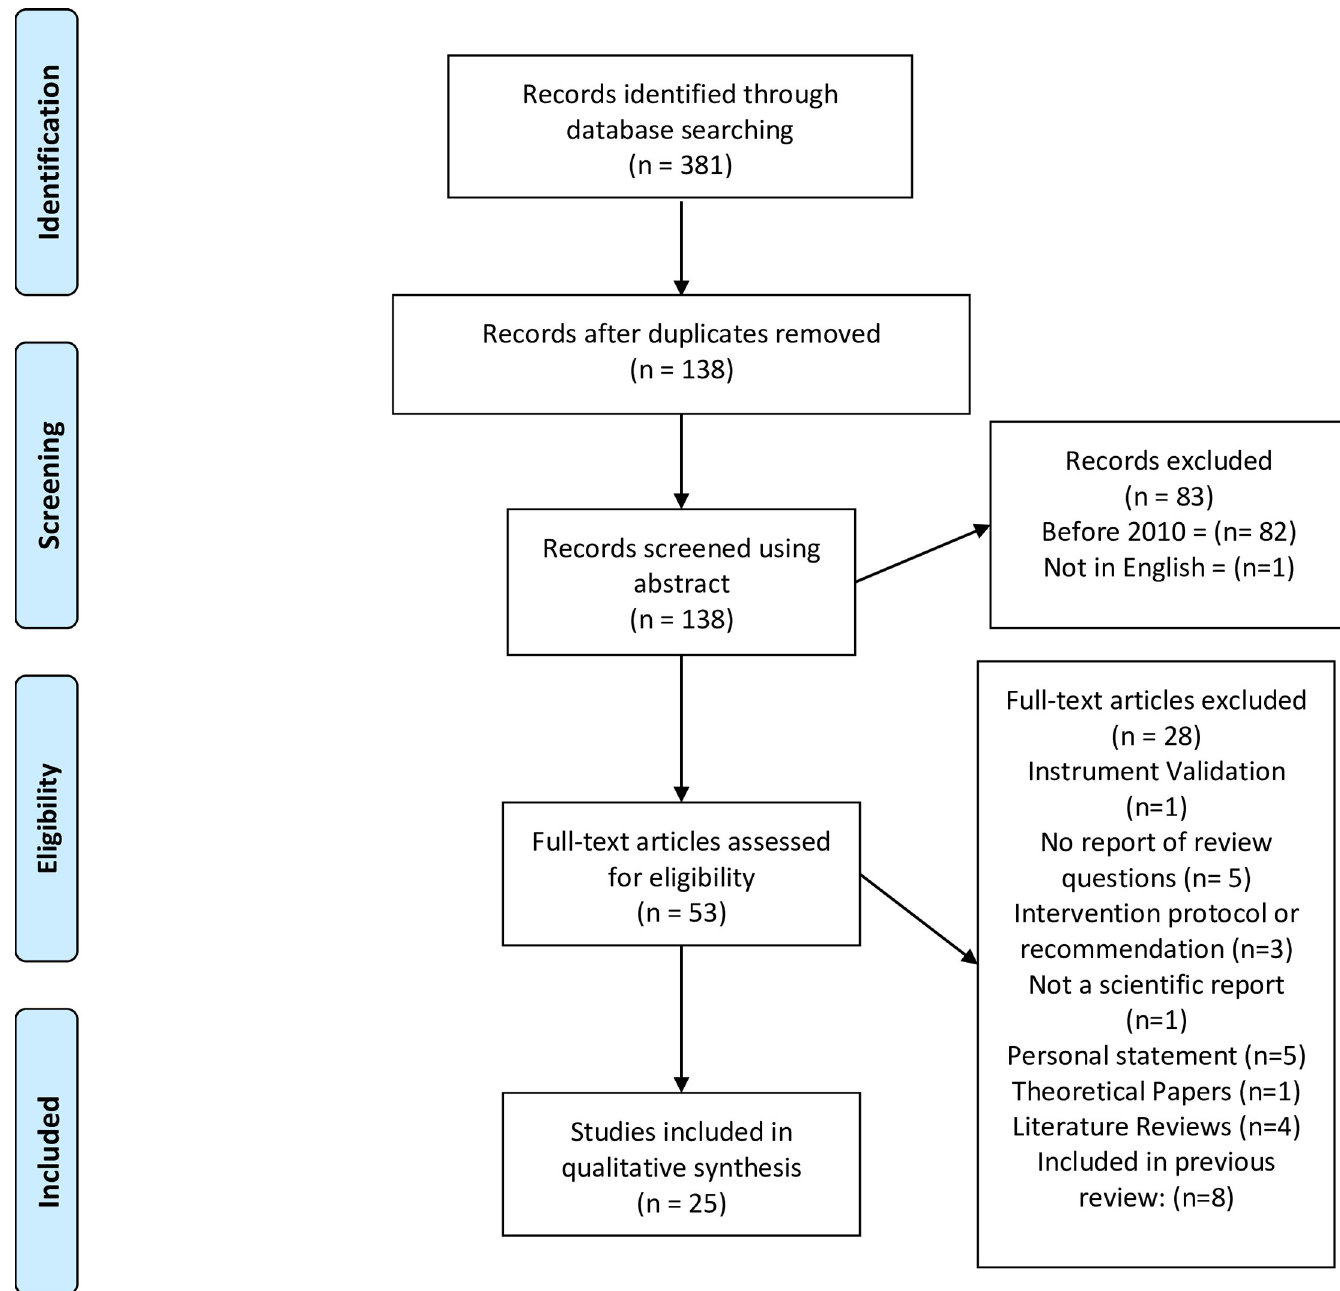
Fig 1. Prisma chart flow. Paper selection and eligibility for the review.